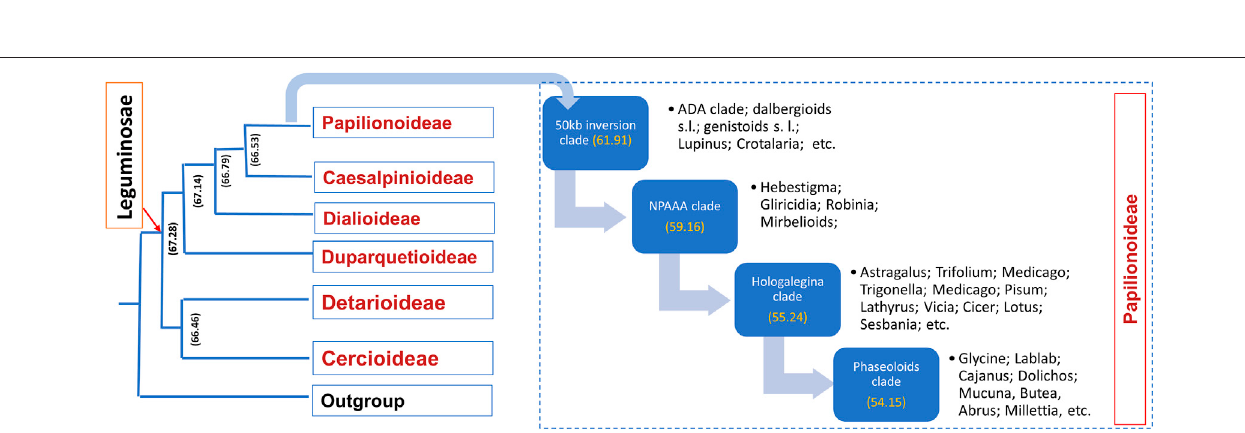
Frontiers in Genetics |